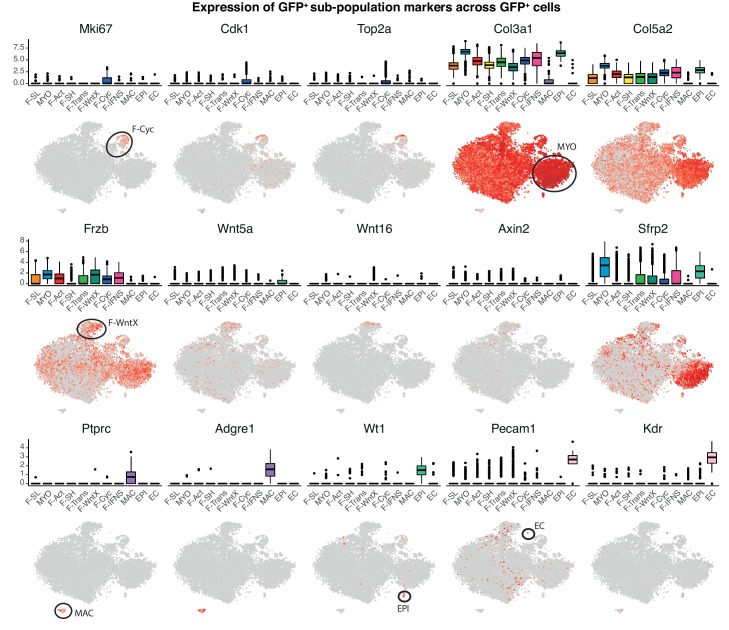
Expression of selected marker genes across GFP+ populations visualized in box and t-SNE plots.Circles indicate relevant population for the displayed marker.